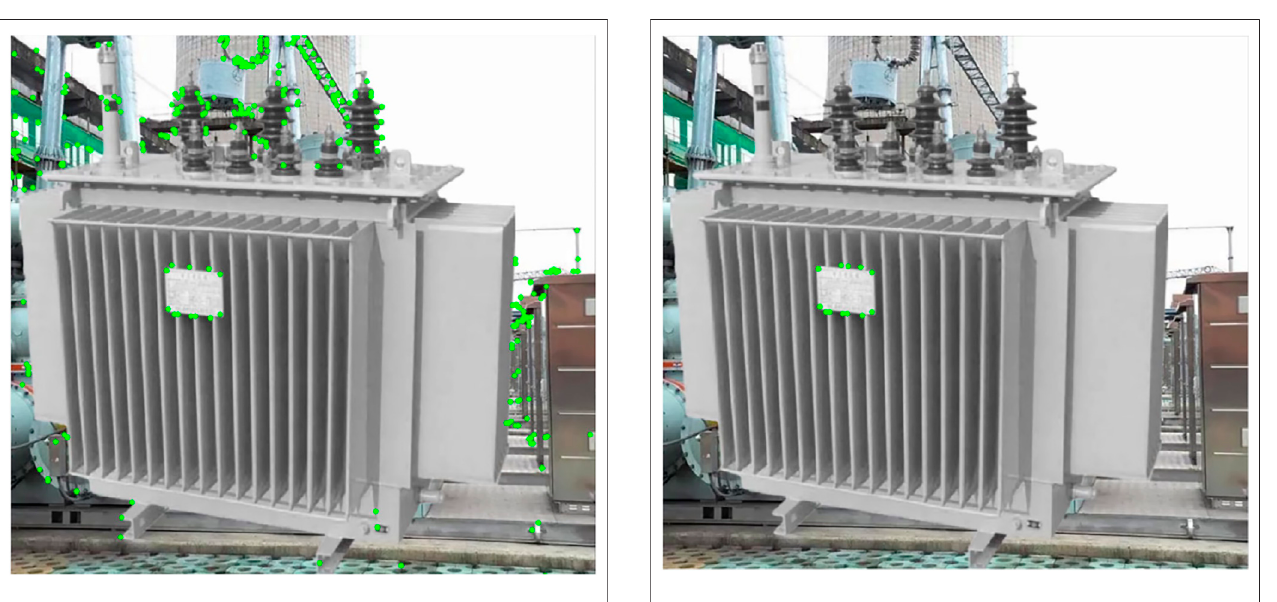
FIGURE 10 | The feature points in the region of interest are represented by green dots, which can more accurately calculate the transformer vibration vector compared with the feature points in Figure 9